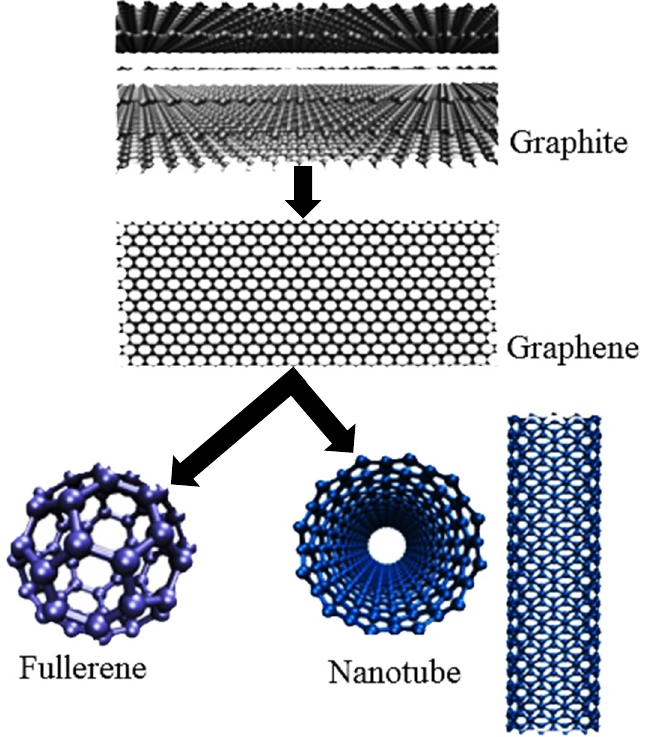
Figure 1. Different allotropes of carbon: 3D graphite, 2D graphene, 1D carbon nanotubes and 0D carbon fullerenes.